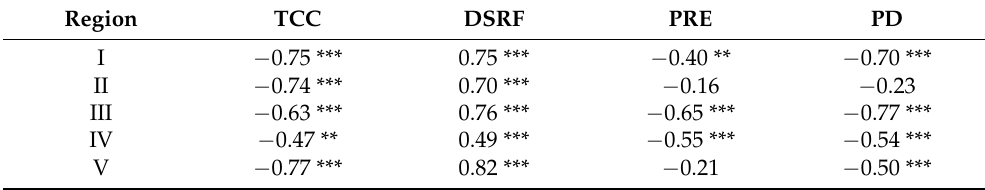
Table 1. Correlation between regional accumulated temperature and influencing factors. Region